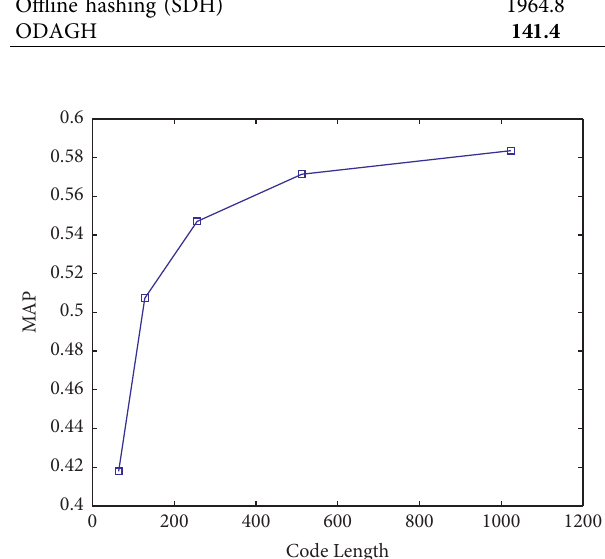
Figure 3: MAP variations with code length of 64, 128, 256, 512,